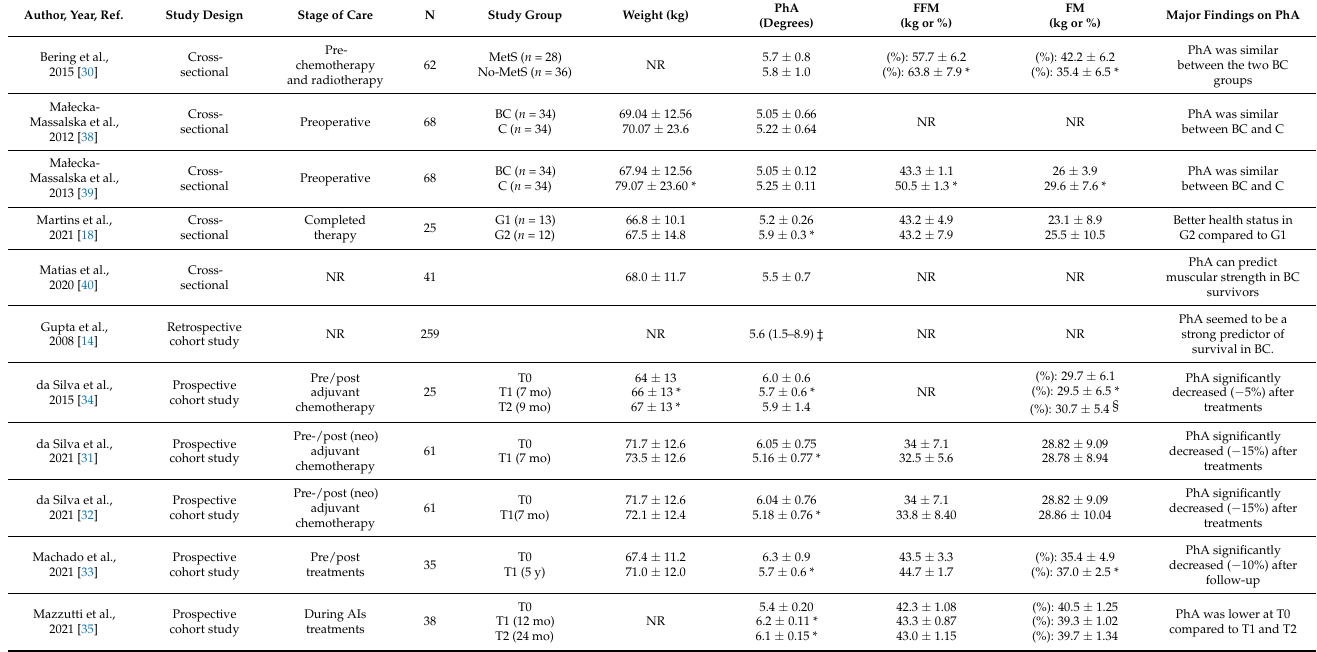
Table 2. Weight, phase angle and body composition variables extracted by observational